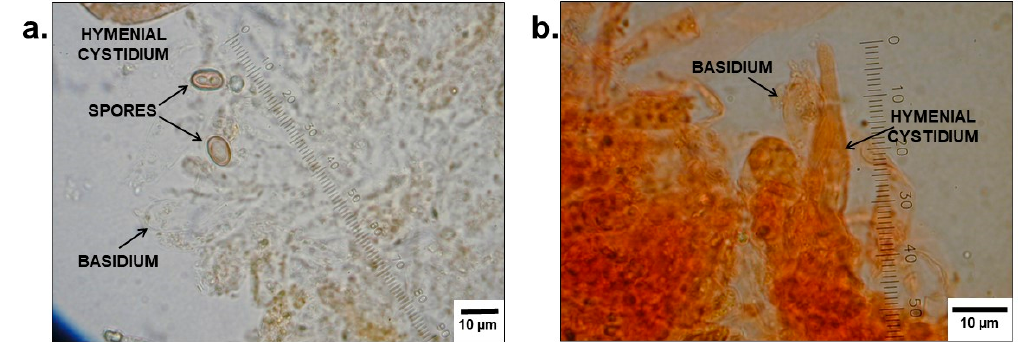
Figure 4. Microscopic images of the lamellar surfaces of mushroom residues in Figure 3, prepared in ( a ) water and ( b ) Congo red, respectively. The spores, basidia, and cystidia of Paxillus involutus can be seen.